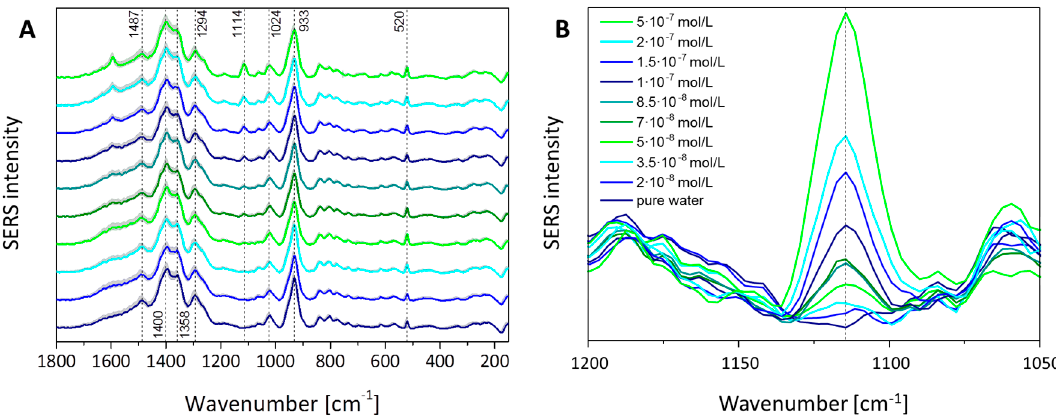
Figure 3. Concentration-dependent surface-enhanced Raman spectroscopy (SERS) signal intensity of sulfamethoxazole (SMX): ( A ) The marker mode of SMX at 1114 cm − 1 is marked and in ( B ) the enlarged Figure section is shown, illustrating the increase in signal intensity with increasing concentration.